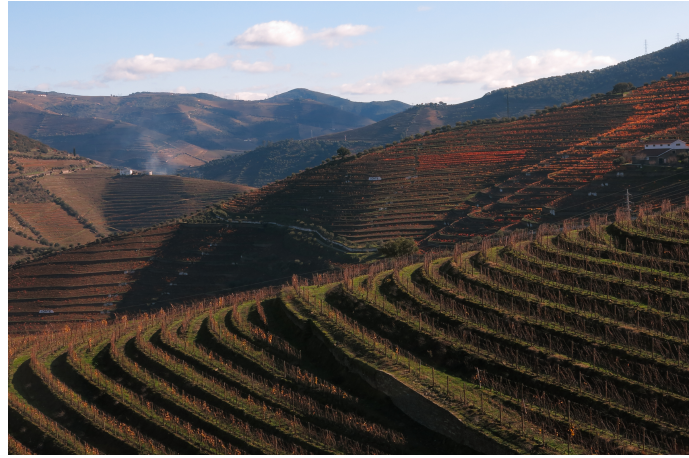
Figure 1. Typical steep slope vineyard in the Douro’s region. The Douro Demarched region (41º 06 (cid:48) 06 (cid:48)(cid:48) N 7º47 (cid:48) 56 (cid:48)(cid:48) W) extends for many Portugal cities, such as Mesão Frio, Peso da Régua, Santa Marta de Penaguião, Vila Real, and